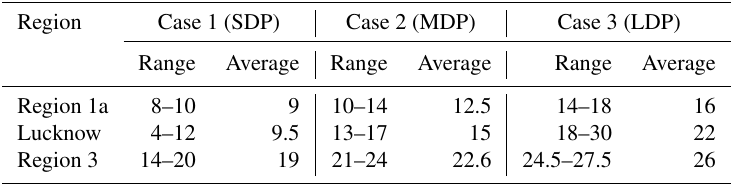
Table 1. Classification of dry phase conditions according to its length for region 1a, Lucknow and